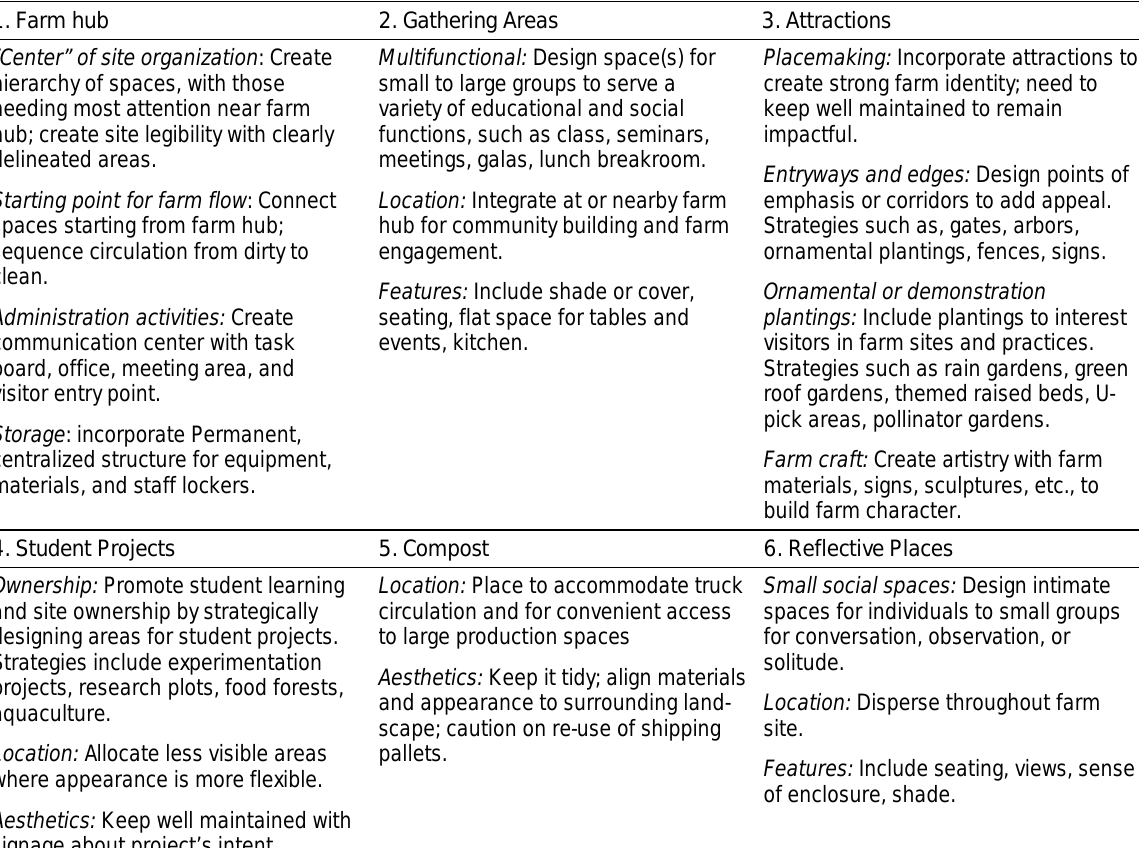
Table 2. Summary of Physical Considerations for Six Domains of Student Farm Site